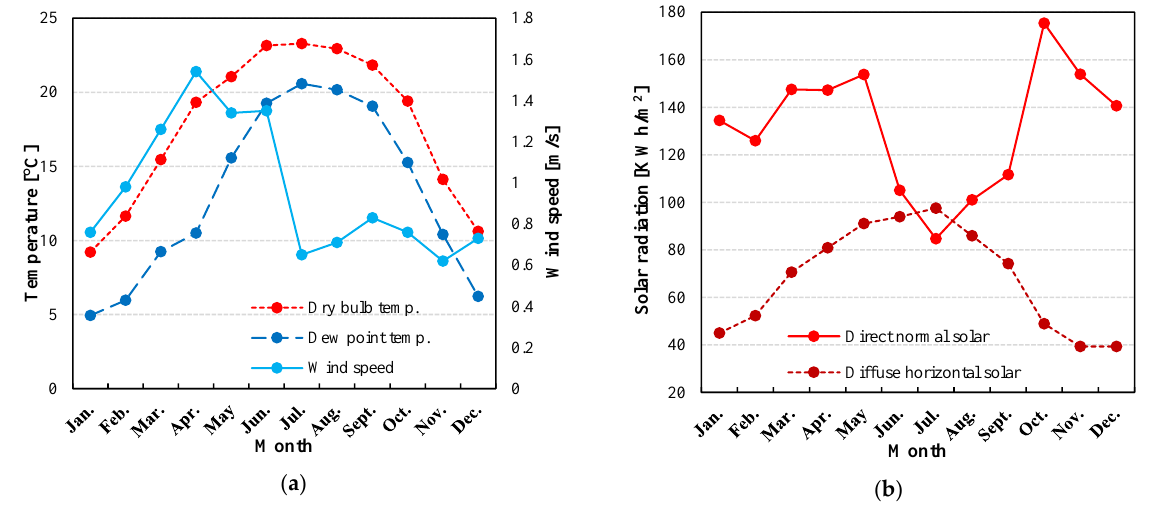
Figure 6. Monthly average values of climatic data in Kathmandu: ( a ) outdoor temperature and wind speed and ( b ) direct normal and diffuse horizontal solar radiation.